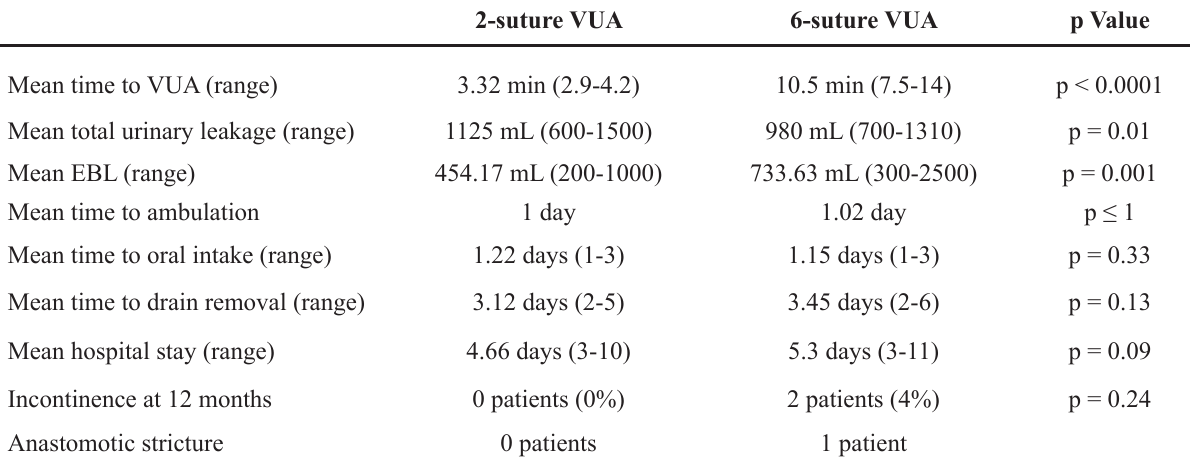
Table 2 – Intraoperative and postoperative parameters as well as functional